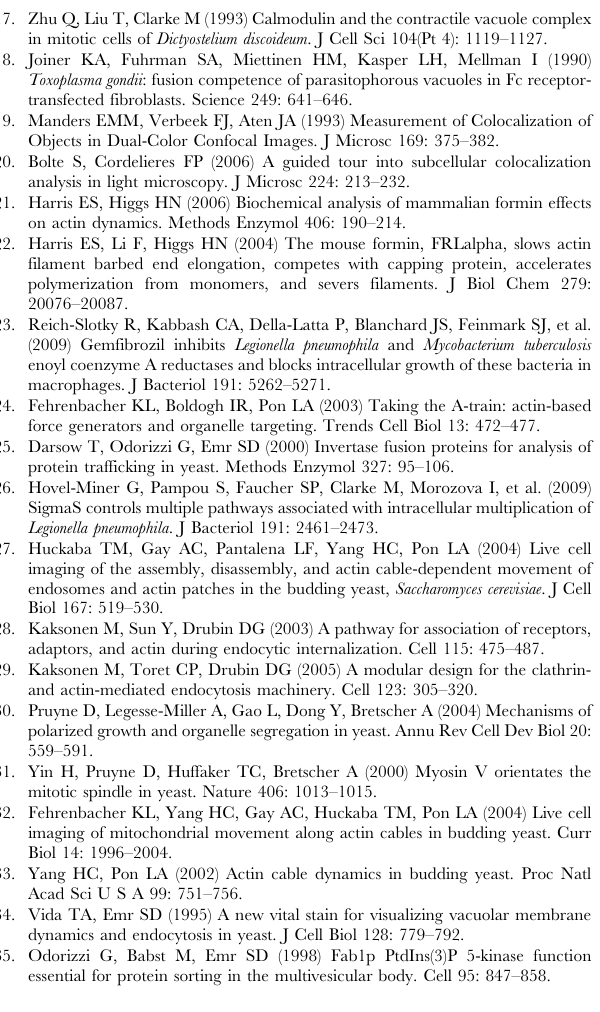
Table S2 Plasmids and oligonucleotides used in this